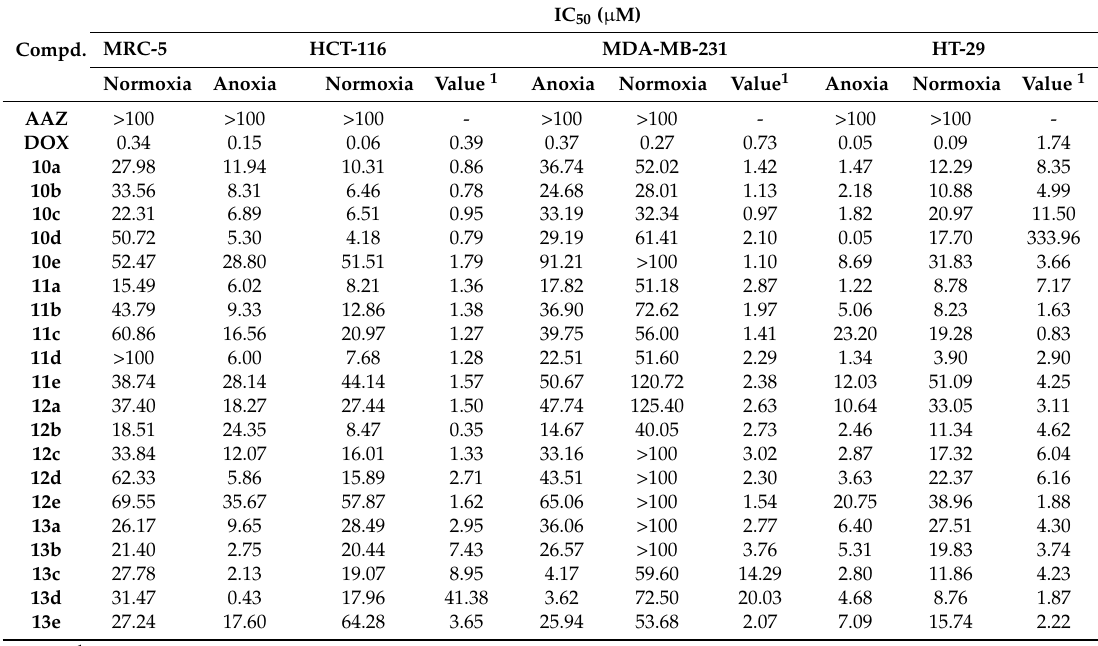
Table 1. IC 50 values of tested compounds against MRC-5, HCT-116, MDA-MB-231, and HT-29.